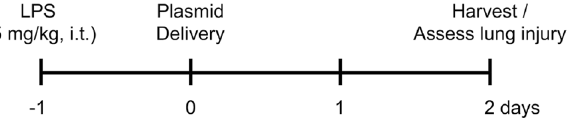
Figure 2. Experimental timeline for treatment of lung injury. Lung injury was established in mice by 5 mg/ kg LPS administered by aspiration and 1 day later, plasmids (either β1, MRCKα, or a combination of the two; 100 µg in 50 µl PBS) were aspirated into the lungs and electroporated using electrodes placed on either side of the chest. Two days after gene delivery, lung injury was